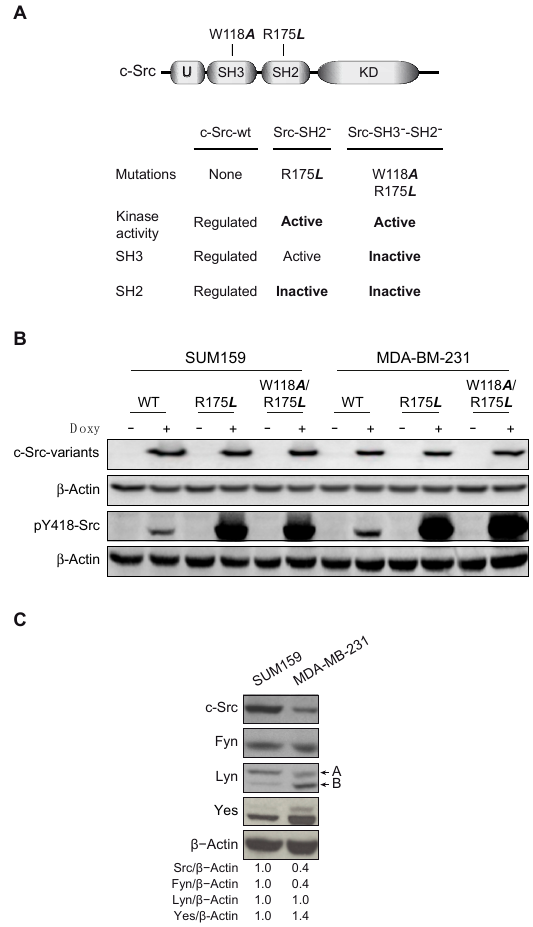
Figure 1. c-Src variants and expression of Src kinases in SUM159 and MDA-MB-231 cells. ( A ) Schematic design of c-Src and the variants employed in this study, which were condition- ally expressed (Tet-On system) upon addition of doxycycline (Doxy, 0.2 µ g/mL) to the cell culture. The R175 L mutation inhibits both intra- and inter-molecular interactions of the SH2 domain of c-Src. The W118 A /R175 L double mutation inhibits both the SH2 and SH3 domains. ( B ) Induction of chicken c-Src variants by Doxy was detected by Western blot (WB) using the EC10 mouse monoclonal antibody that specifically recognizes chicken c-Src and β -Actin as a loading control. ( C ) Comparative expression of Src kinases in SUM159 versus MDA-MB-231 cells determined by WB. Actin was used as a loading control and the ratio of kinase/actin in SUM159 was considered as